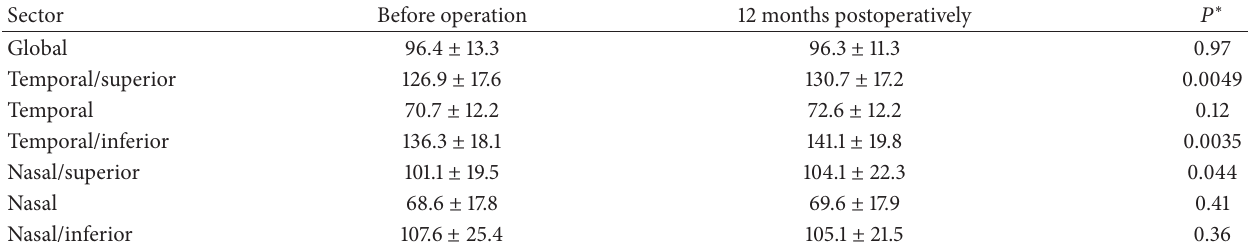
Table 4: Comparison of circumpapillary global and sectoral RNFL thickness ( 𝜇 m) at 12 months after surgery ( 𝑛 = 38